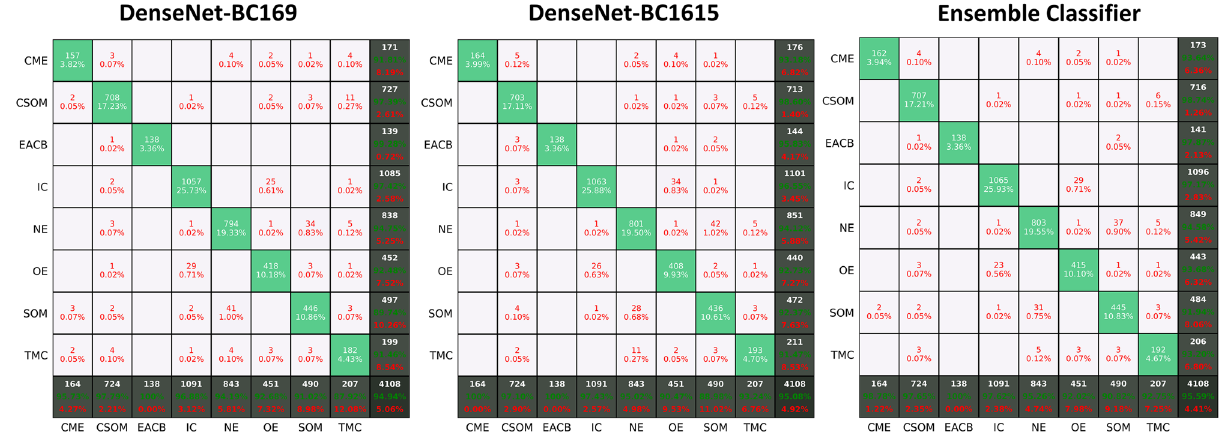
Figure 7. Confusion matrices for DensNet-BC169, DensNet-BC1615, and ensemble classifier at the test sample sets having a maximal accuracy.